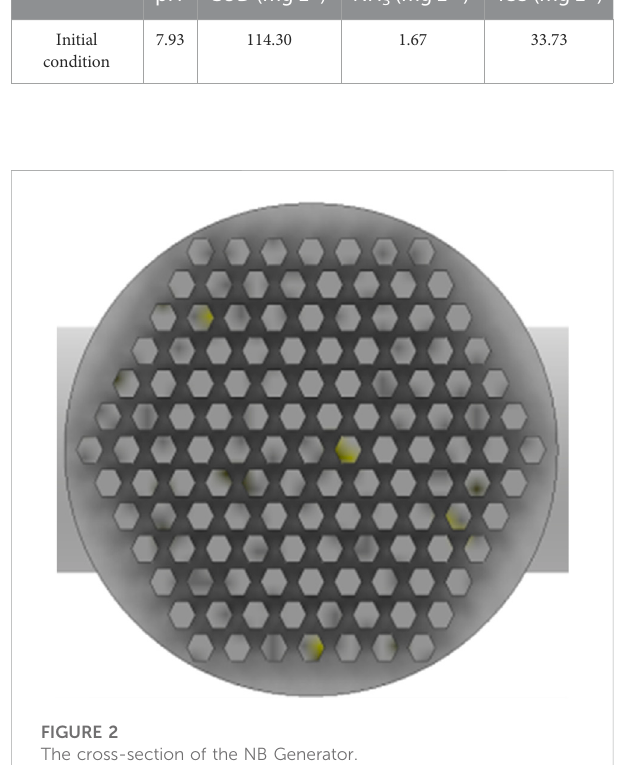
FIGURE 2 The cross-section of the NB